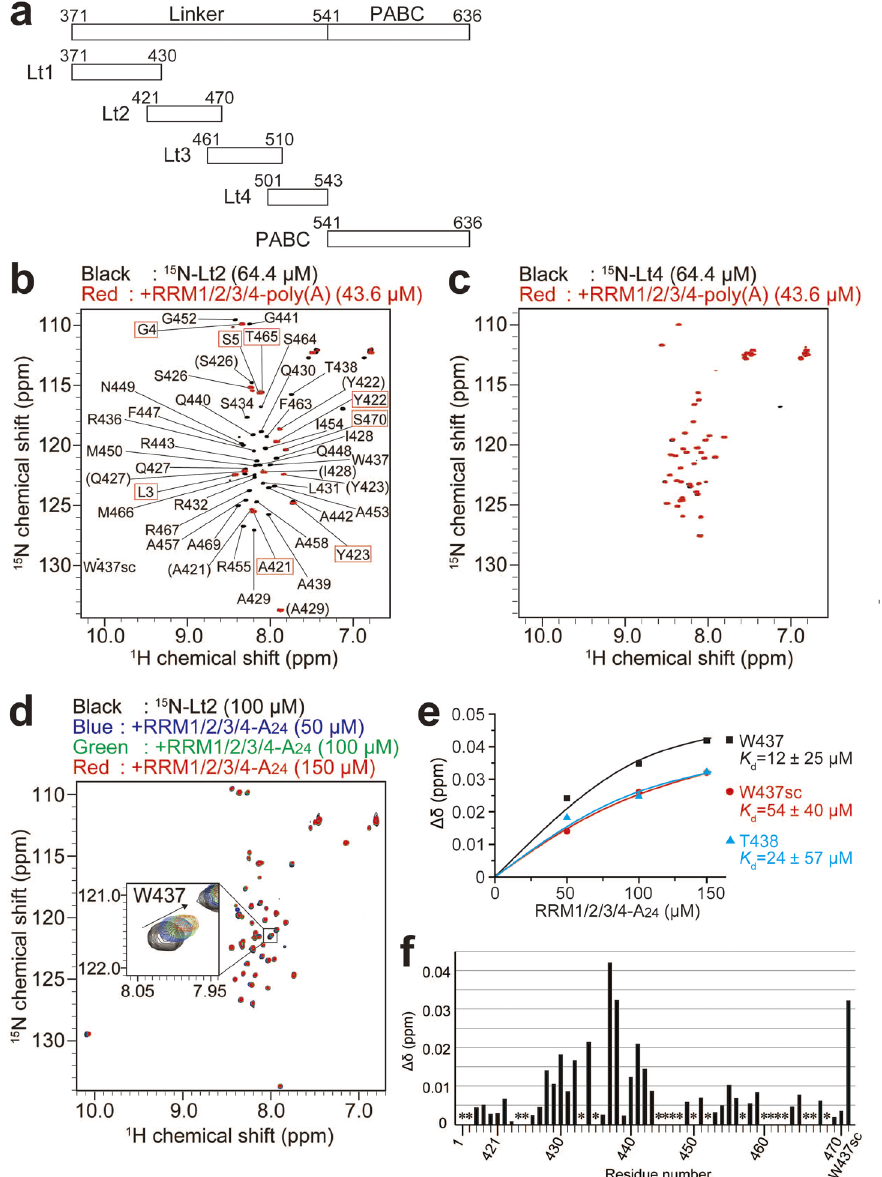
Figure 4. 1 H- 15 N HSQC spectra of Lt2 and Lt4 in the presence and absence of RRM1/2/3/4-poly(A). ( a ) Fragments of the linker-PABC region used in this study. ( b , c ) 1 H- 15 N HSQC spectra of 15 N-labeled Lt2 ( b ) and Lt4 ( c ) at 64.4 μ M, in the presence (red) and absence (black) of 43.6 μ M RRM1/2/3/4-poly(A). The peak labels in the parentheses in panel (b) represent the minor peaks of the split signals. The 9 NMR signals with peak labels enclosed by the red box in the panel (b) did not disappear upon addition of RRM1/2/3/4-poly(A). ( d ) 1 H- 15 N HSQC spectra of 15 N-labelled Lt2 at 100 μ M in the presence and absence of RRM1/2/3/4-A 100 (green) and 150 μ M (red). The NMR signal of W437 in the black box is enlarged. ( e ) The estimation of the dissociation constant ( K d ). The chemical shift changes of W437 sidechain (sc), W437 and T438 were plotted against RRM1/2/3/4-A 24 concentration in 1 H- 15 N HSQC spectra of 15 N-labelled Lt2 at 100 μ M in the presence and absence of RRM1/2/3/4-A 24 at 50, 100 and 150 μ M. The K d values were estimated by the curve fitting of the chemical shift changes of the NMR signals for W437sc, W437 and T438, by a 1:1 binding model using the formula,